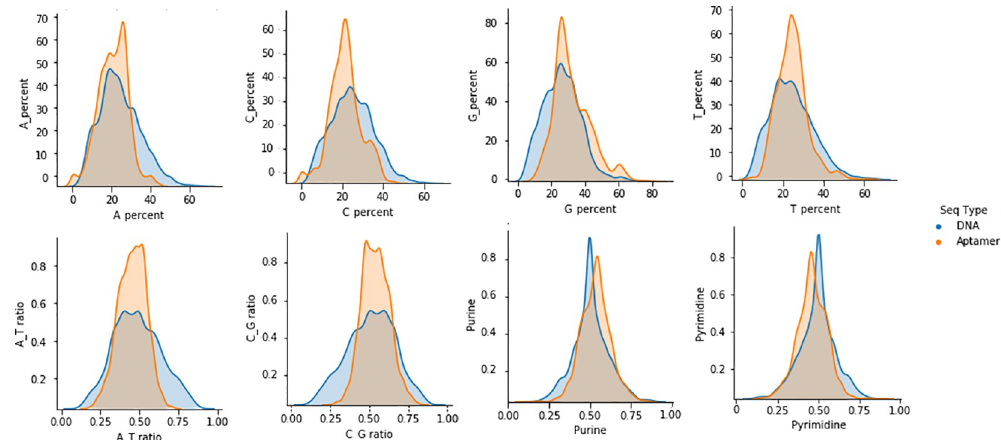
Fig 2. Plot of the DNA vs. aptamer features. Variables are against themselves to show the distribution. The blue area depicts DNA sequences while orange area depicts aptamers sequences.